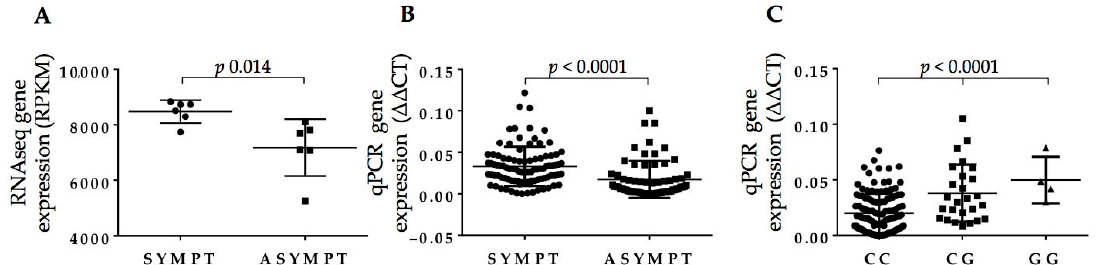
Figure 2. BIRC6 gene expression levels ( A ) by RNA-Seq in the original VSMC samples extracted from 14 patients [20], and ( B ) by qPCR in extracts of carotid plaques from 70 asymptomatic and 104 symptomatic patients normalized for GAPDH and β -actin levels. In ( C ), BIRC6 gene expression levels from ( B ) are shown classified according to rs35286811 genotype.